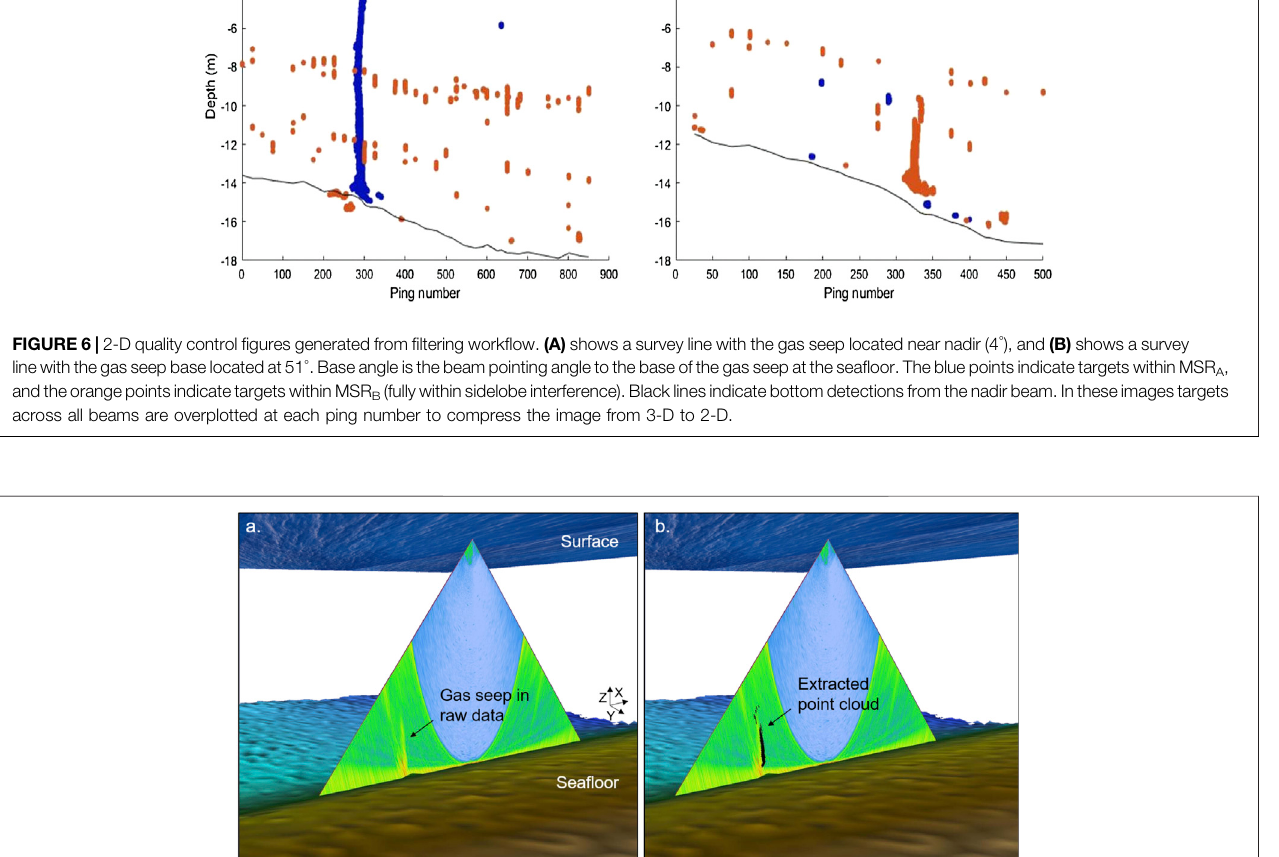
Frontiers in Remote Sensing |